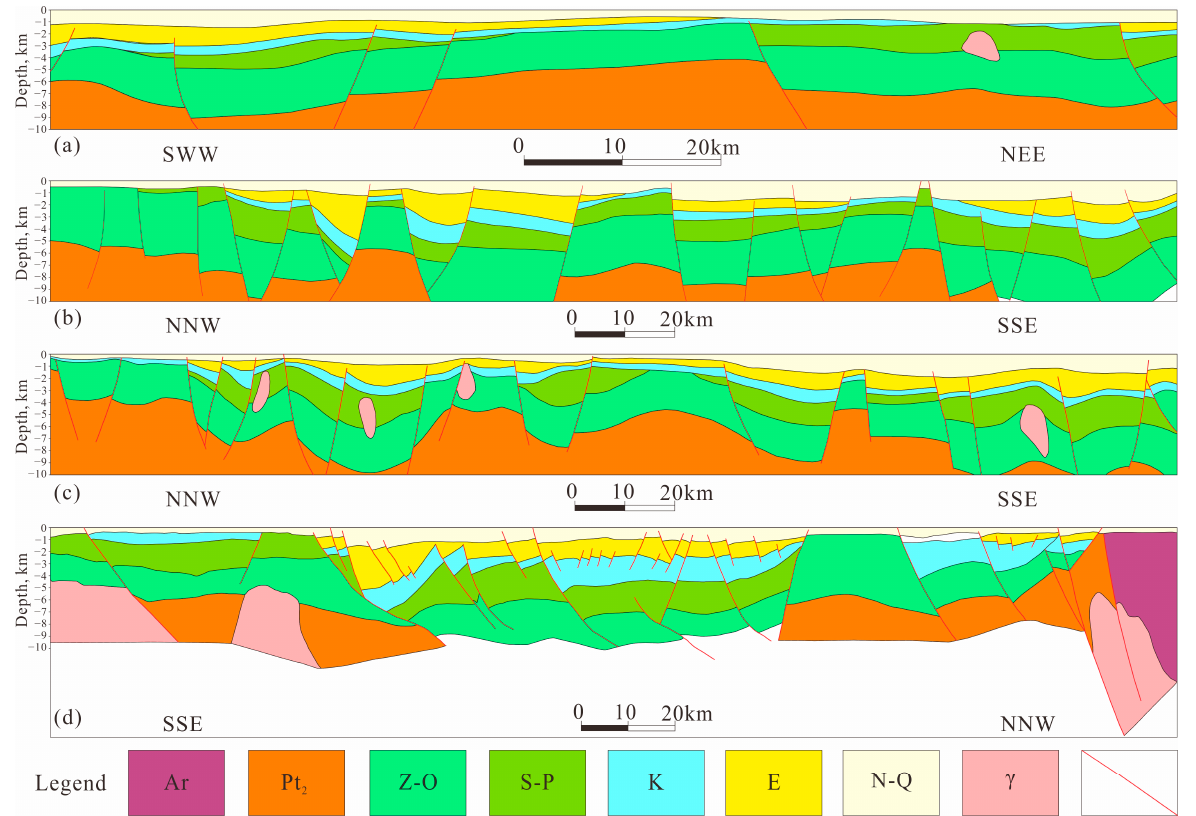
Figure 2. Geological interpretation sections in the North Jiangsu Basin (( a , c ) are modified from Wang, et al. [4] ( b ) is revised from oil company reports, ( d ) is modified from Chen [13], Qiao, et al. [14]). The four sections are shown in Figure 1B. Ar, Archean; Pt 2 , Mesoproterozoic; Z-O, Ediacaran to Ordovician; S-P, Silurian to Permian; K, Cretaceous; E, Paleogene; N-Q, Neogene to Quaternary; γ , Magmatic rock. Reprint with permission [4].